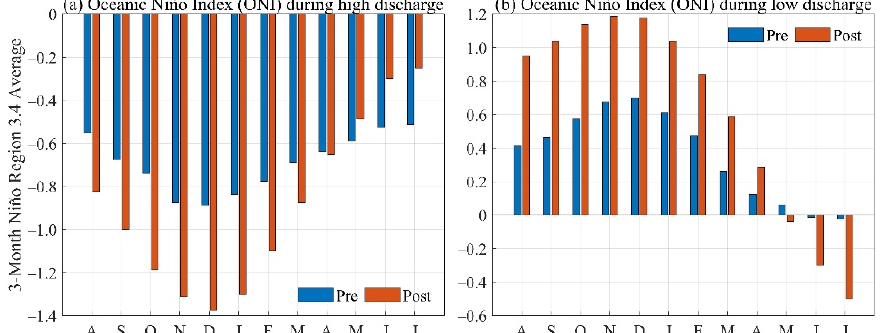
Figure 5. Annual cycle of the El Niño Ocean Index (ONI) during ( a ) high and ( b ) low discharge events, pre- and post-breakpoint. Blue bars for events pre-1986, and orange for events post-1986.